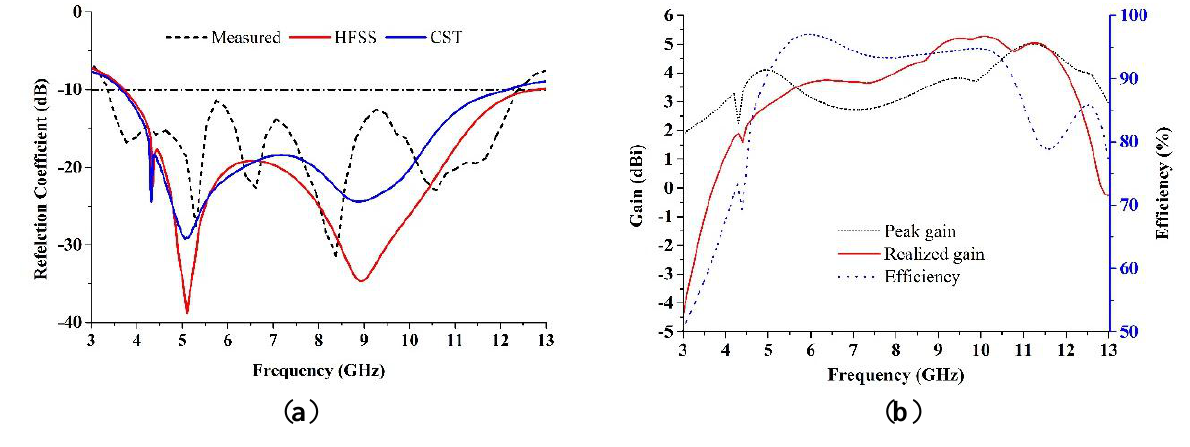
Figure 9. ( a ) Comparison between the simulated and measured reflection coefficient and ( b ) measured gain and radiation efficiency of the proposed UWB MTM